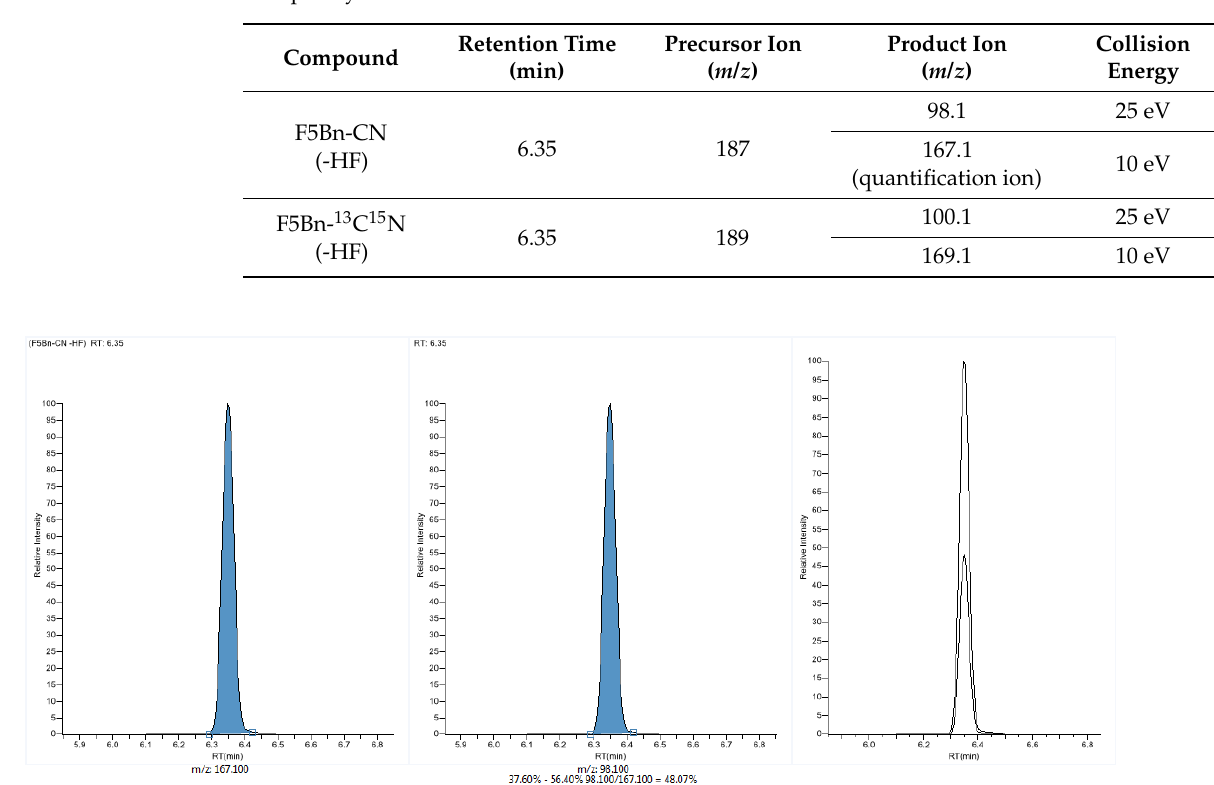
Figure 2. Mass spectra of the cyanide derivative PFB-CN in cyanide spiked blood samples, ob- tained with the following ionization techniques: ( A ) NCI, ( B ) PCI, ( C ) EI positive.